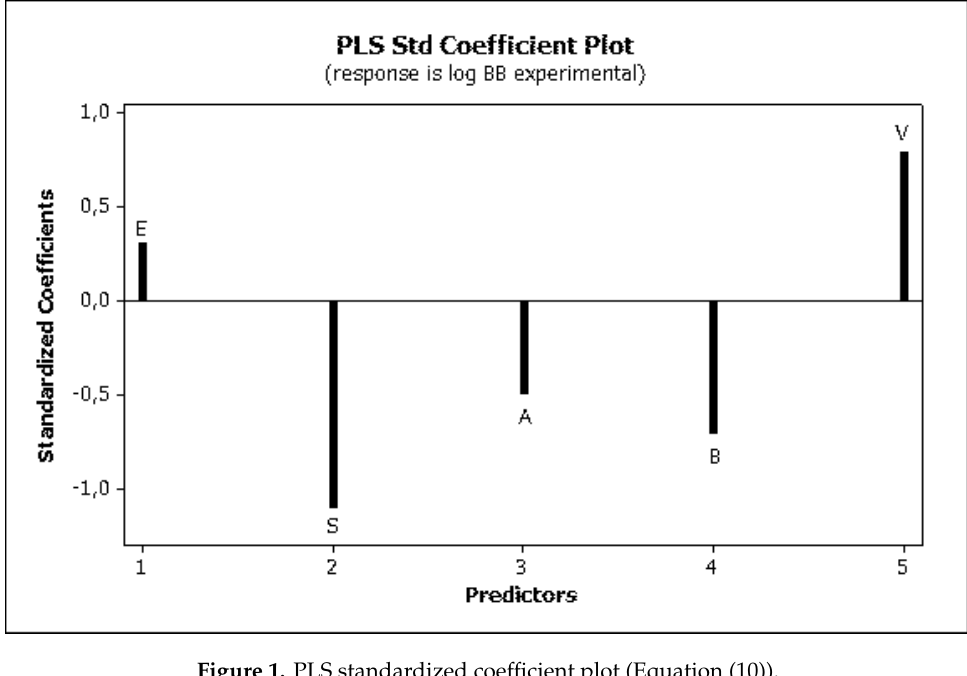
Figure 1. PLS standardized coefficient plot (Equation (10)).